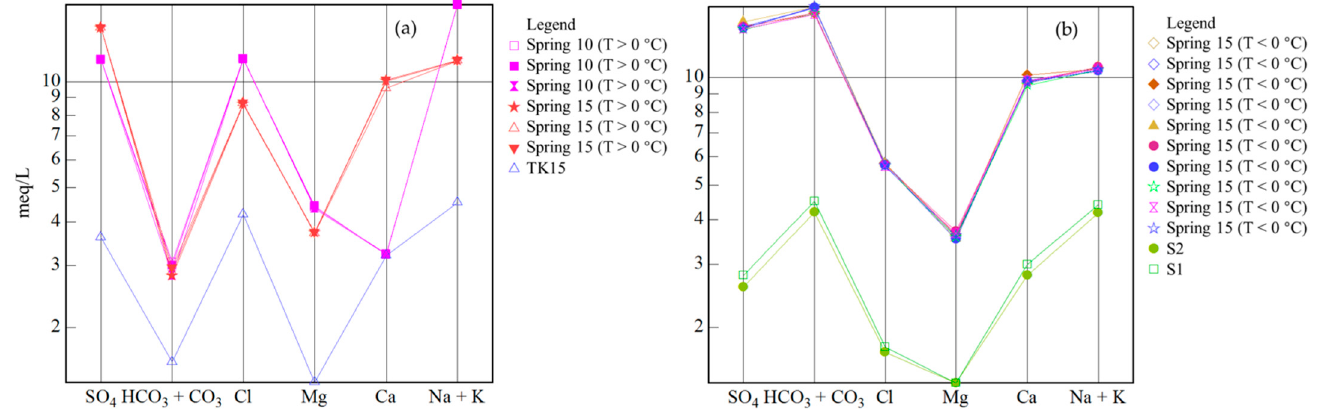
Figure 8. Schoeller diagrams of samples from Spring 15 and springs in the Turpan Basin [35]. ( a ) Spring 15 samples collected at T > 0 °C and the TK15 sample from Turpan Basin; ( b ) Spring 15 sam-